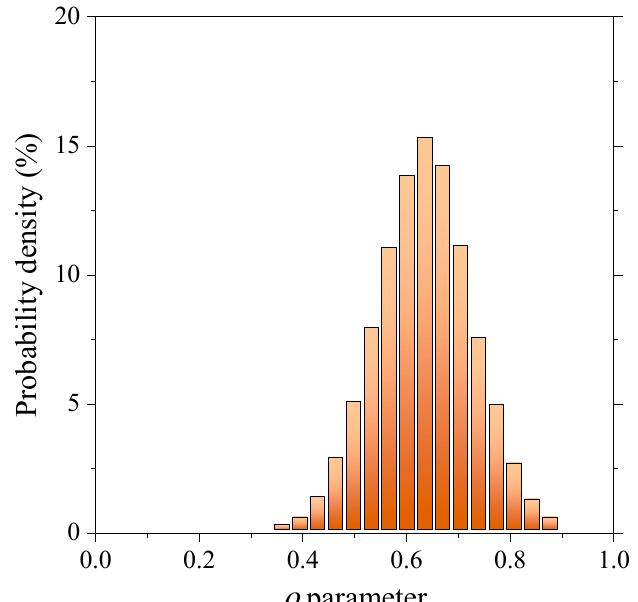
Figure 2. Normal distribution of ρ parameter of FE constructed model.